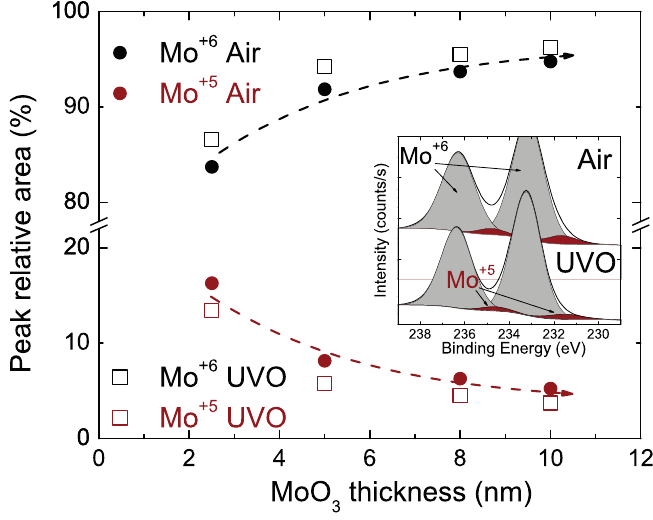
Figure 2. Relative content of Mo +6 and Mo +5 oxidation states for different MoO 3 film thicknesses (2.5, 5, 8 and 10 nm) and post-deposition treatments (air exposure and ultraviolet light ozone—UVO). Inset shows the fitted XPS spectra for both Mo 3d states identified (8 nm). Lines are a guide to the